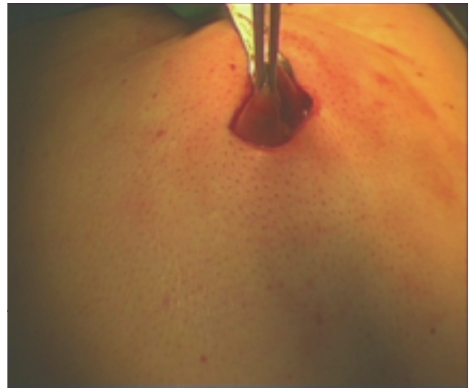
Figure 1: Endoscopy revealed stomach wall erosion with the gastric band partially (2/3) migrated into the gastric lumen. Figure 2: Stomach was grasped at the anterior site and brought outside the abdomen.